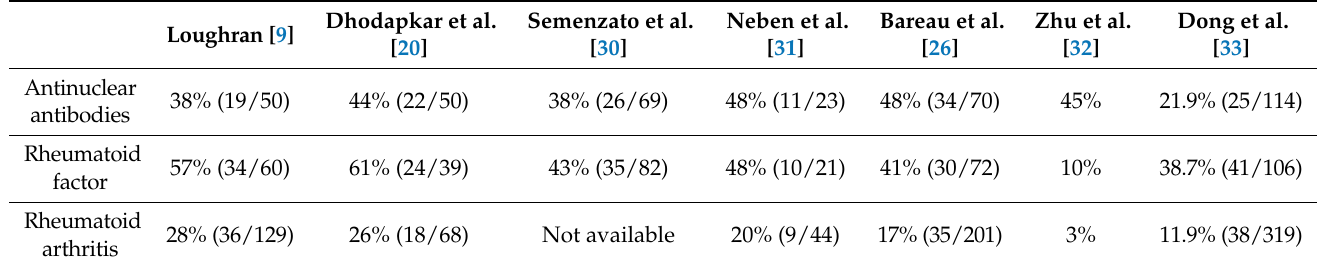
Table 2. Frequency of antinuclear antibodies, rheumatoid factor, and rheumatoid arthritis reported in T-LGL leukemia